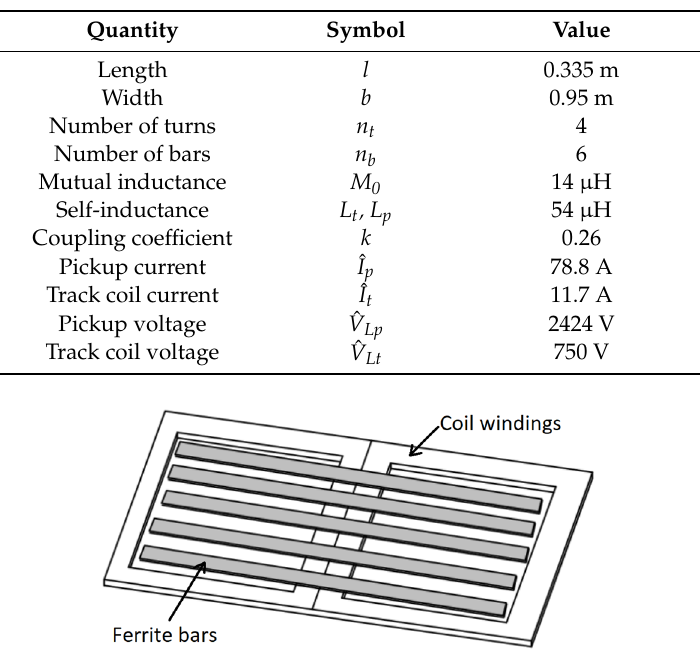
Figure 10. DD coil